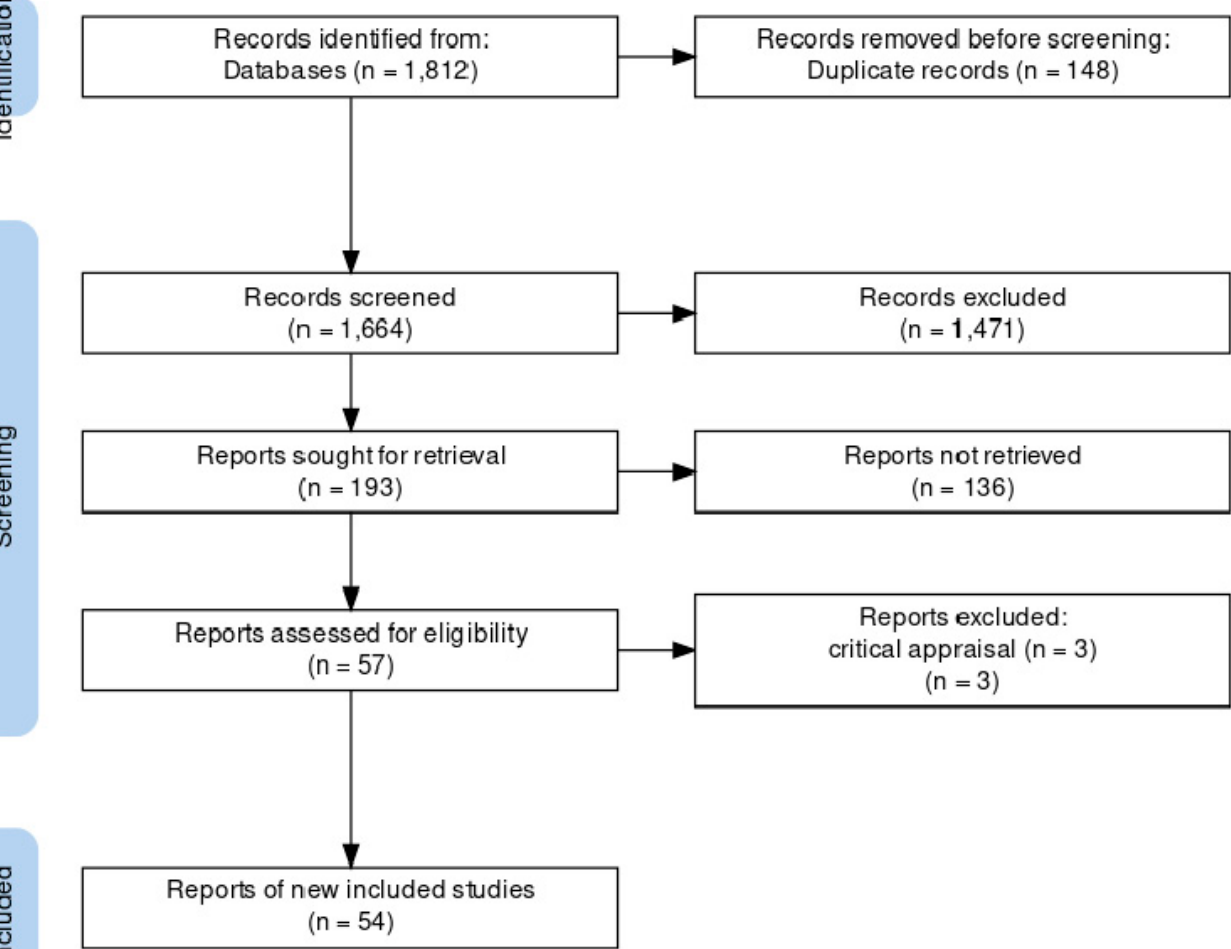
Figure 1. PRISMA 2020 flow diagram of included studies.